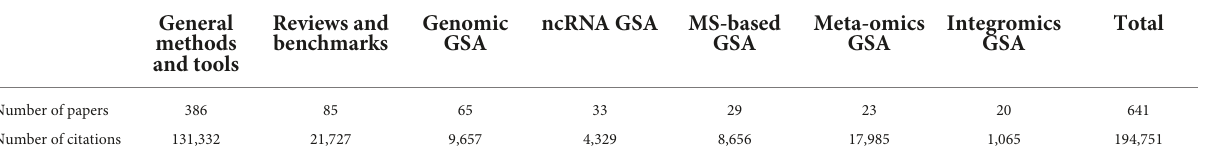
TABLE 2 Statistics of GSARefDB